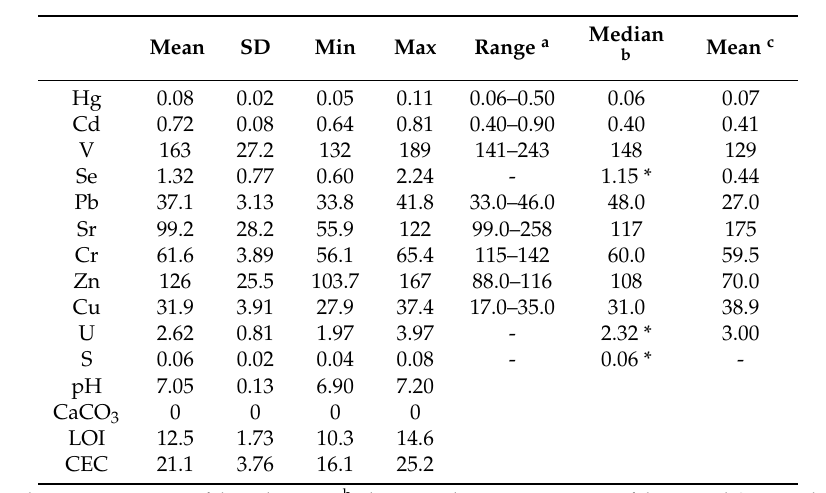
Table 1. Variable concentrations in control soil (n = 5) compared with relevant published data a–c ([18] a,b , [23] c ). S (total sulphur), and LOI (loss on ignition) in %, trace elements in mg/kg, and CEC in mEq/100 g.